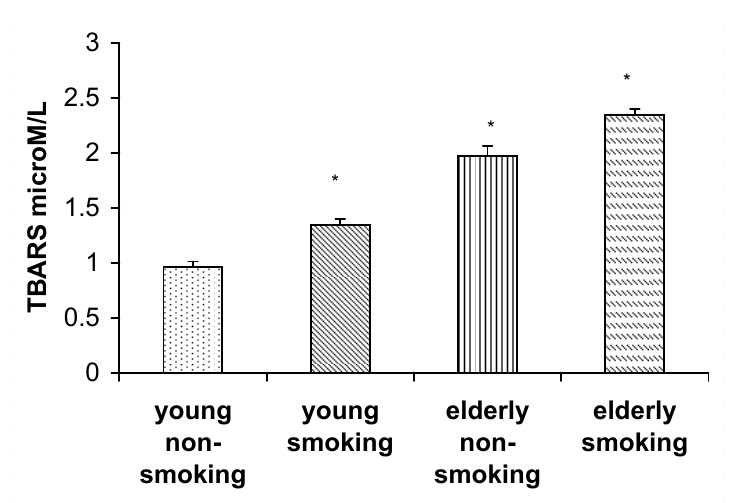
Fig. 2 TBARS levels in plasma of young and elderly non-smoking and smoking volunteers (mean ± SE; * P < 0,001 vs. young non-smoking; asterisk represents P < 0.001 vs. elderly non-smoking).